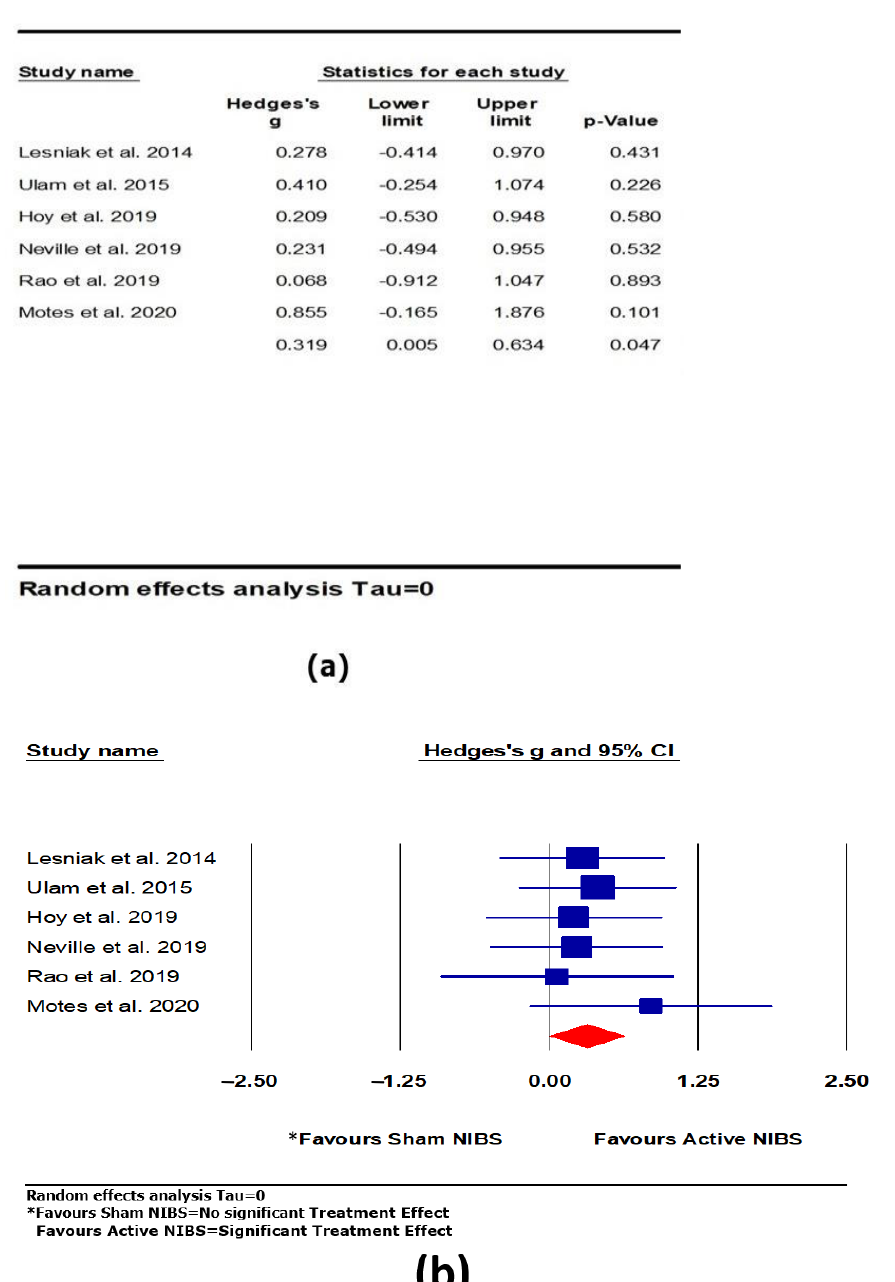
Figure 5. The effect of non-invasive brain stimulation (NIBS) on memory; ( a ) summary table for each study; ( b ) forest plot for each study [38,55–59,61].